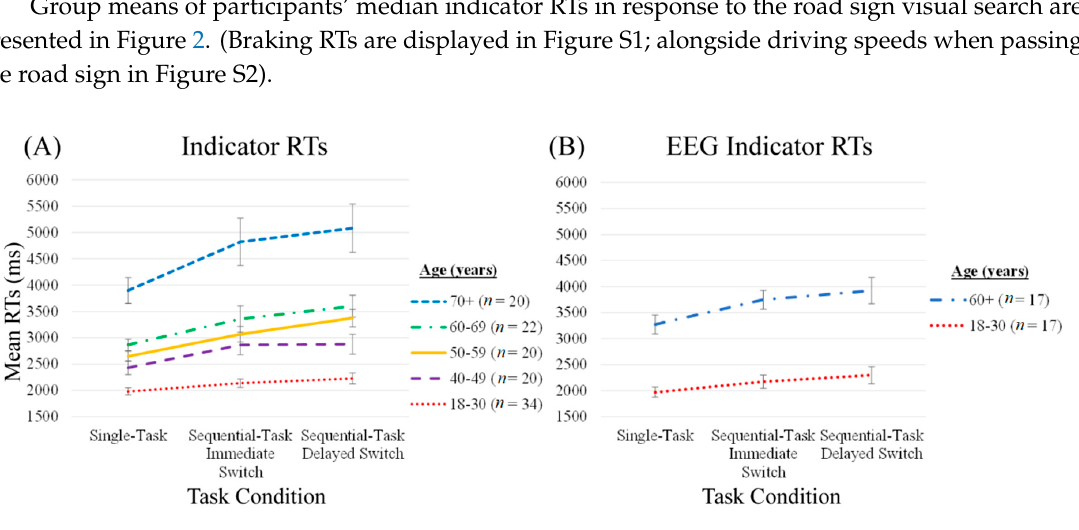
Figure 2. Group means of participants’ median indicator RTs in all participants ( A ) and in the subset of participants with EEG recordings ( B ). Note that the data subset shown in B is included in the overall data shown in A and in all analyses conducted with this data. Vertical bars represent the standard error of the mean.